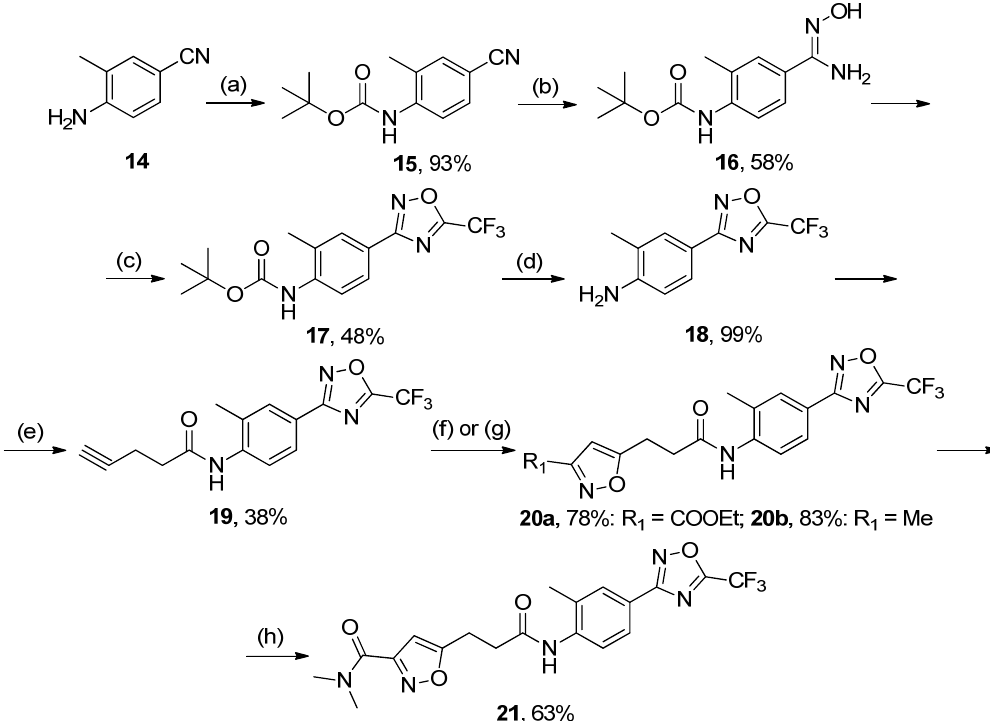
Scheme 3. Synthesis of 2-methyl-4-(5-(trifluoromethyl)-1,2,4-oxadiazol-3-yl)phenylamide of 3-(3-substituted isoxazol-5-yl)propionic acids 20a,b and 21 . Reagents and conditions: (a) Boc 2 O, 85 °C; (b) NH 2 OH·HCl, K 2 CO 3 , EtOH abs , reflux; (c) (CF 3 CO) 2 O, pyridine, 80–90 °C; (d) CF 3 COOH, DCM, rt; (e)